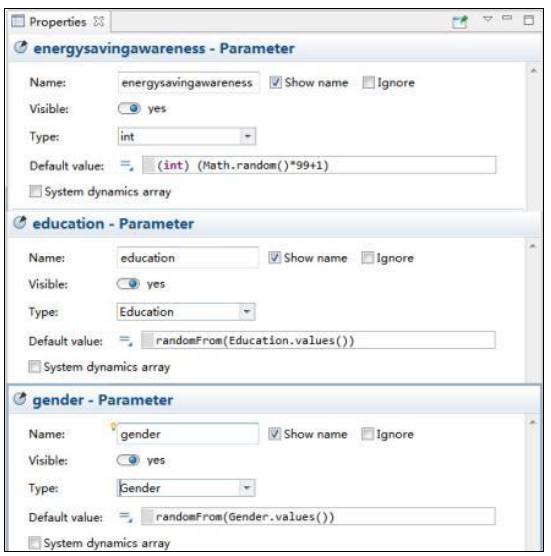
Figure 6. Personal characteristic parameter assignment command.